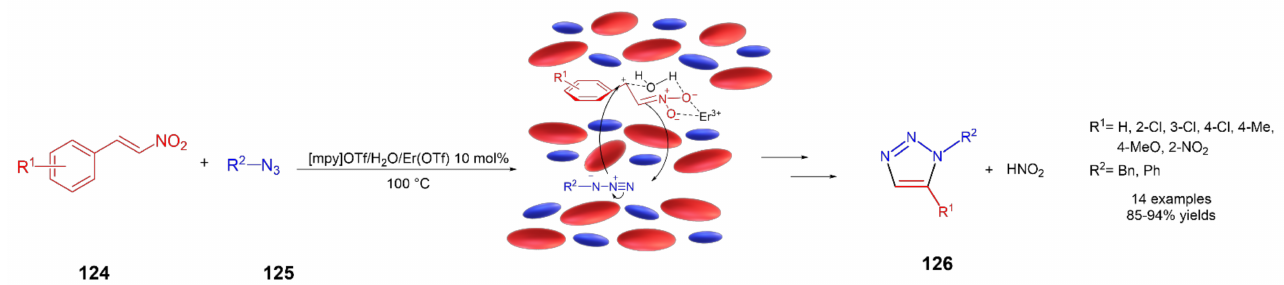
shapes represent the cation [mpy] +, and the red shapes the anion [OTf] − of the IL